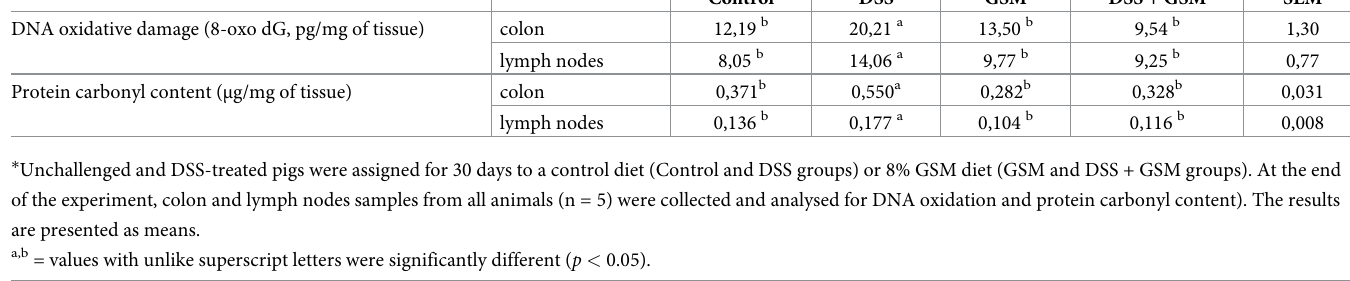
Table 2. Effect of GSM diet on DNA oxidative damage and on protein carbonylation.